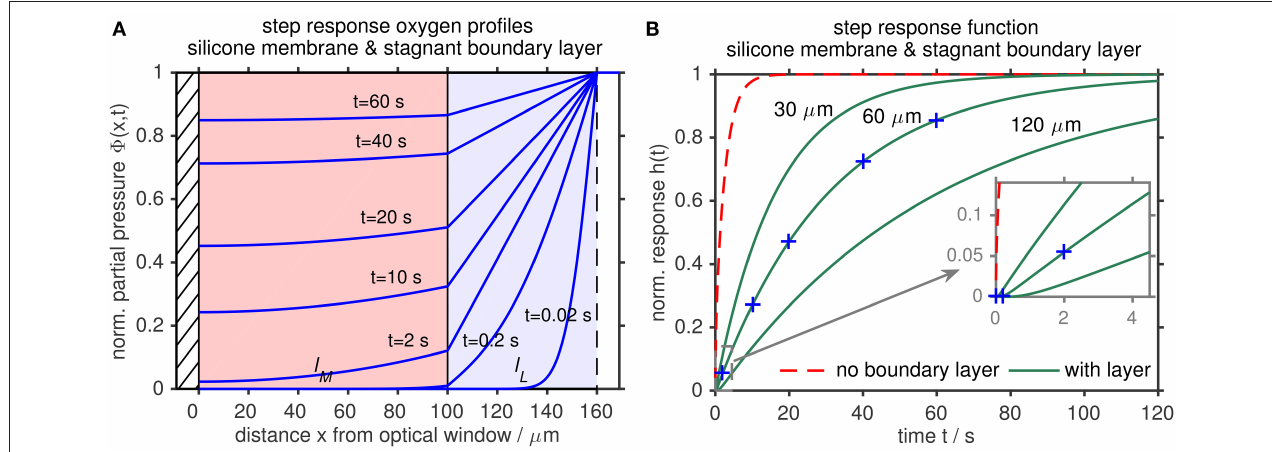
FIGURE 5 | Stagnant boundary layer diffusional model of an O 2 optode to a step change in ambient O 2 levels at 25 ◦ C. The optode consists of a silicone membrane (0 ≤ x ≤ l M , l M = 100 µ m, Aanderaa optode standard foil, pale red) with impermeable boundary (optical window, hatched) on one side and a stagnant liquid boundary layer ( l M ≤ x ≤ ( l M + l L ), l L = 60 µ m, pale blue) on the other side. (A) Normalized partial pressure response inside the two layers: O 2 has first to diffuse through the boundary layer to change O 2 levels inside the sensing foil, which limits the optode time response. (B) Normalized O 2 step response function h ( t ) for different boundary layer thicknesses l L (green) and for a gas phase time response without liquid boundary layer ( l L = 0 µ m, dashed red) (after Bittig et al., 2014).